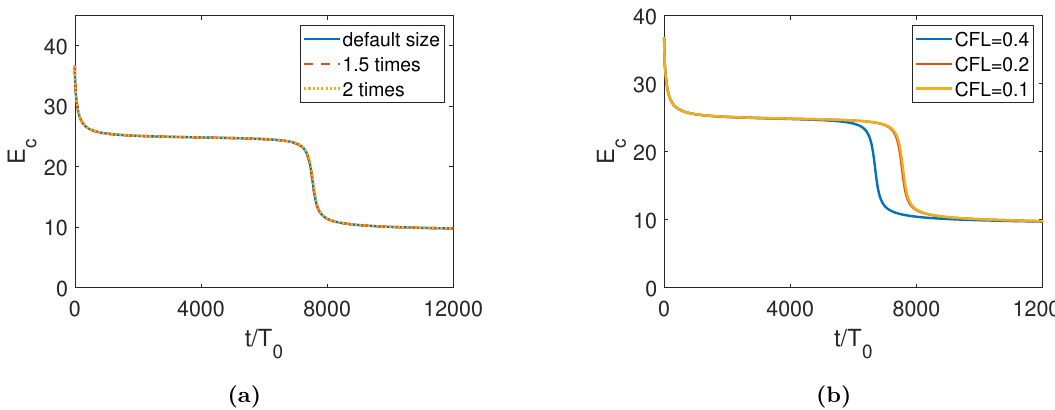
Figure 16. Convergence study with different physical box sizes (left) and different Courant- Friedrichs-Lewy (CFL) factors (right). In the left plot, the blue solid line is the physical box size we use for most of our simulations, which is 102.4 in each spatial direction, and the red and orange lines are 1 . 5 and 2 times of the default size respectively with d x kept at